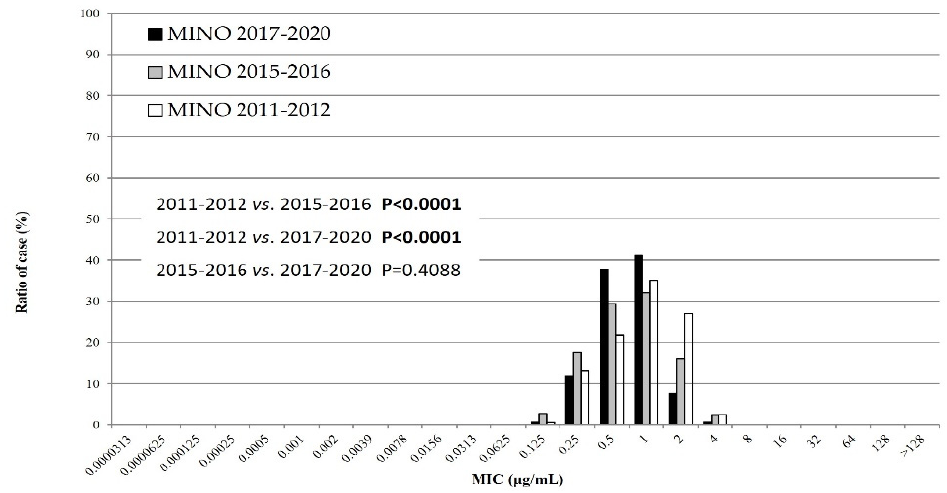
Figure 3. MIC distribution of minocycline against M. pneumoniae isolates during the three periods: